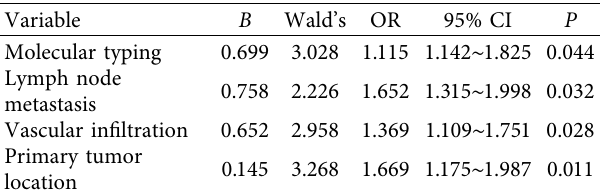
Table 4: Multivariate logistic regression analysis on prognosis of IDC patients after modified radical